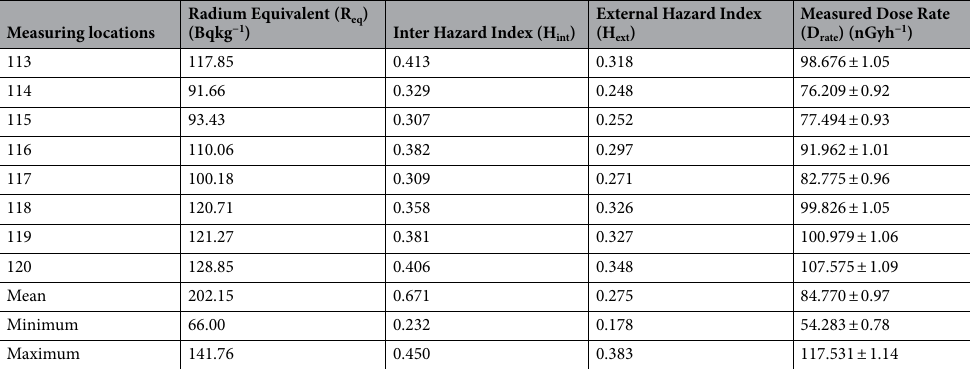
Table 2. The calculated value for a radiological parameter, Radium Equivalent, Inter Hazard index, External hazard index and Dose rate for all sampling location.